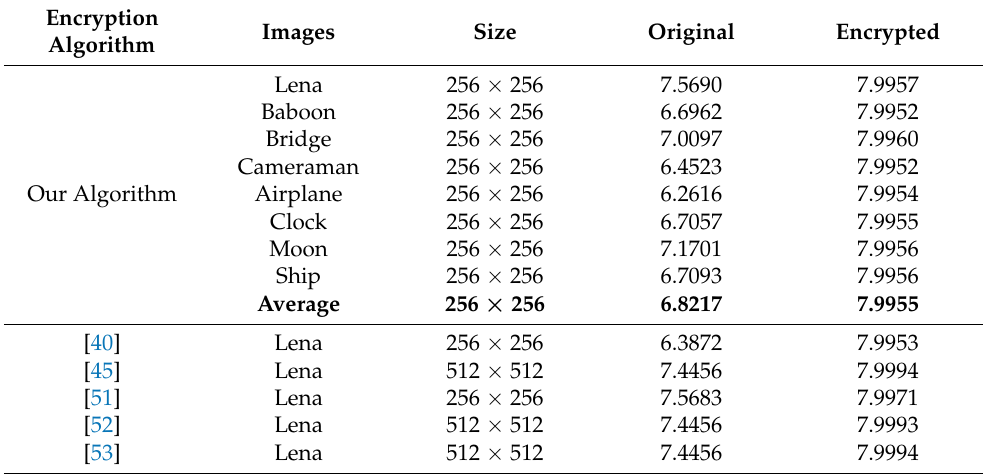
Table 3. The information entropy (IE) results analysis between our proposed image encryption scheme and other